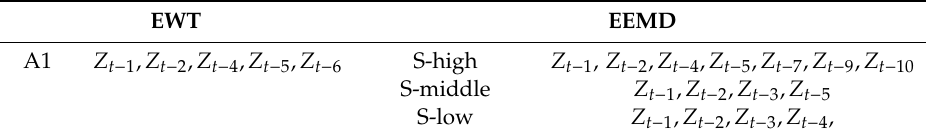
Table 3. Input factors selected by the PACF method of “Yangdong